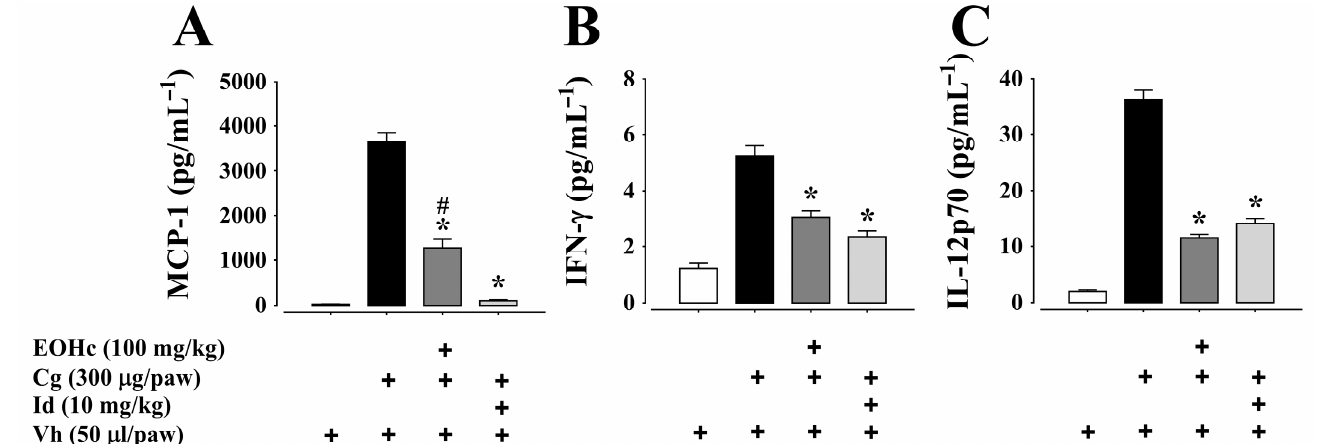
Figure 5. Inhibitory effect of essential oil of Hyptis crenata (EOHc) 100 mg/kg on MCP-1 ( A ), IFN- γ ( B ), and IL-12p70 ( C ) at 3rd h of edema induced by carrageenan. EOHc or the vehicle (0.1% Tween 80) was administered, orally, 1 h before carrageenan intra-plantar injection for edema induction. The dosage of cytokines was made in paw homogenate after 3 h of edema induced by intra-plantar injection of carrageenan (Cg, 300 µg/paw) or of its vehicle (Vh, 0,9% NaCl solution, 50 µL/paw). Id, indomethacin (positive control). *, p < 0.05, vs. carrageenan; #, p < 0.05 vs. positive control (One way ANOVA followed by Bonferroni´s test). n (number of animals) = 6 for all panels. “+” means in presence of.